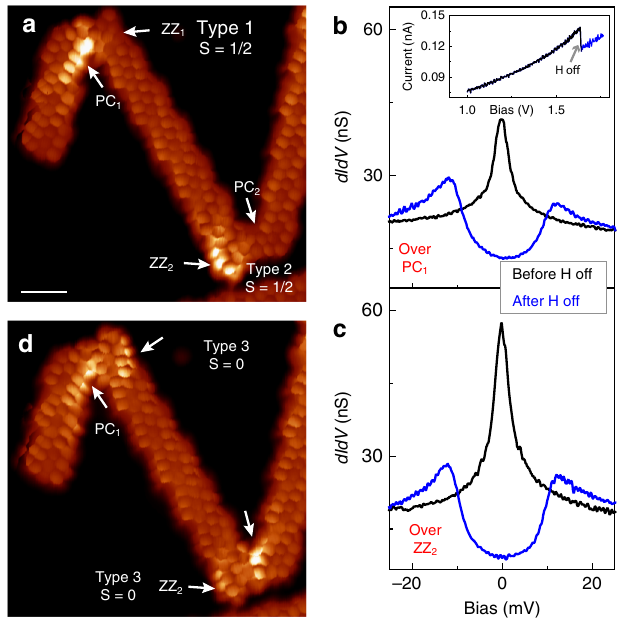
Fig. 4 Spin manipulation by electron-induced removal of extra H-atoms. a Constant-height current image of two junctions with extra H atoms ( V = 8 mV) (scale bar 1 nm). b , c d I /d V spectra taken over PC 1 and ZZ 2 regions (indicated in a ) before (black) and after (blue) the dehydrogenation processes. Inset in b shows the current during the process of